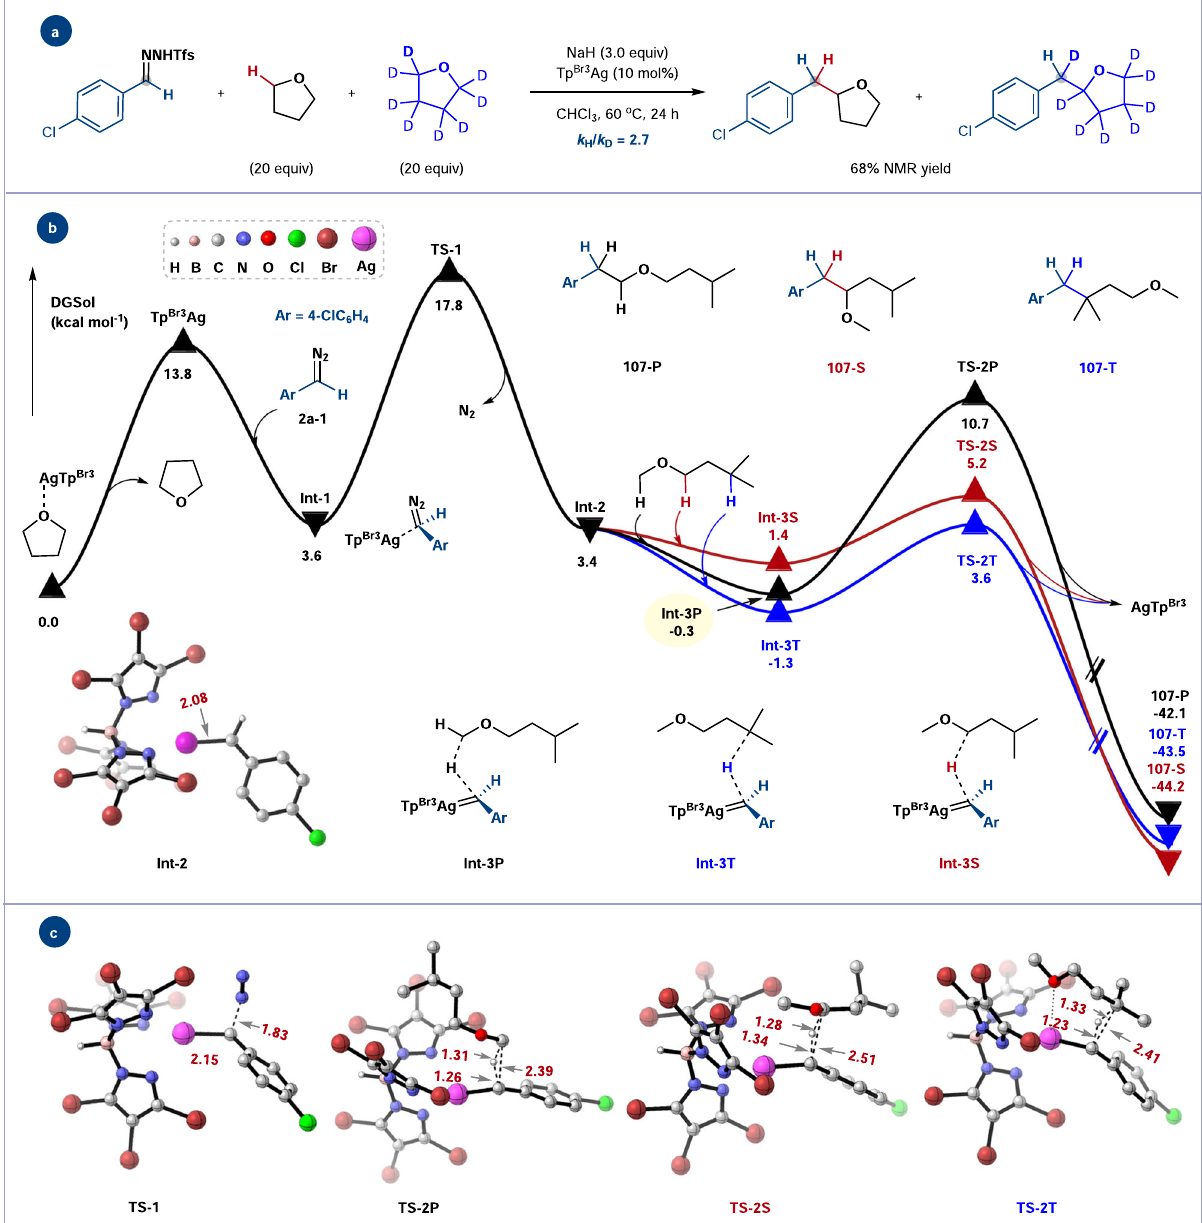
Fig. 8 Mechanistic studies. a One-pot competition KIE experiment. b Computed energy pro fi les for the silver-catalyzed carbene insertion into C – H bonds of methyl isoamyl ether. c Optimized geometrical structures for transition state structures. Calculations were performed at the M06/[6 – 31 + G(d,p)/ SDD(Ag)] level of theory in chloroform within the SMD model. Energies are given in kcal mol − 1 and distances in